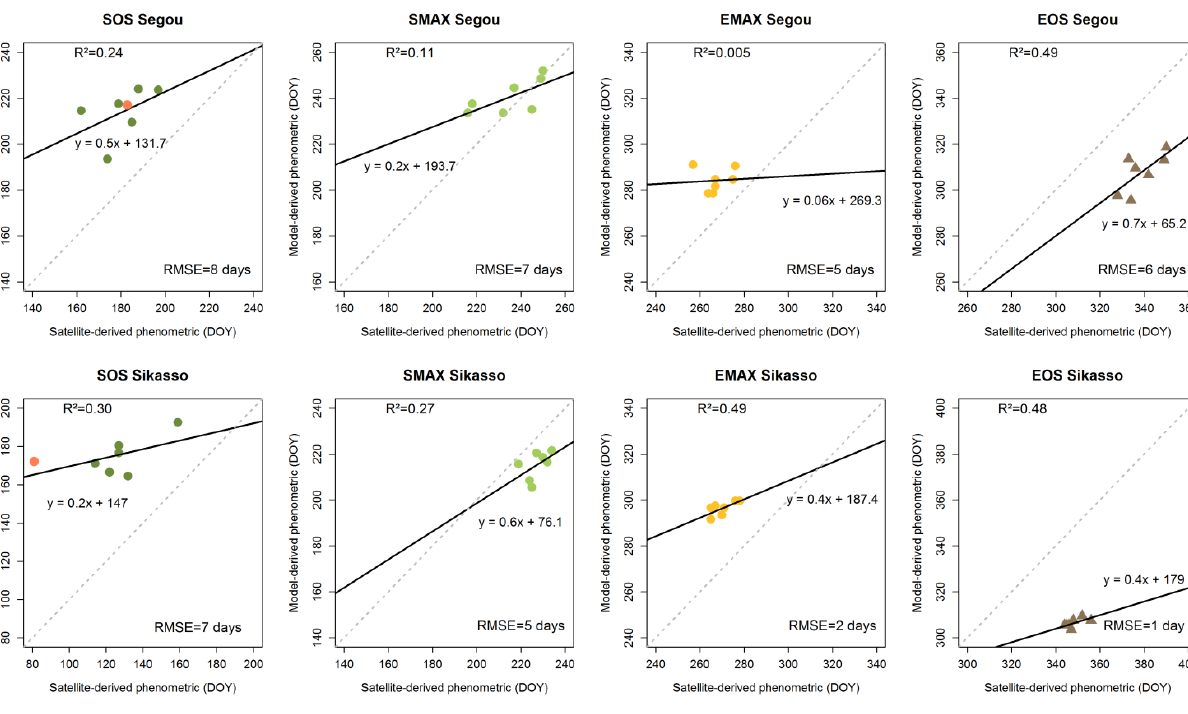
Figure 8. Linear regression of the satellite- and model-derived phenometric median values for Segou and Sikasso from 2002 to 2008. The diagonal dotted lines represent the 1:1 lines. The SOS points represented by the orange circles were inconsistent for the rainfall distribution, which is discussed below (Section